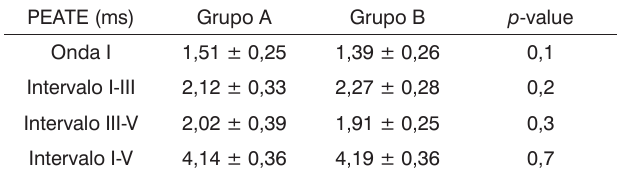
Tabela 3. Latências dos potenciais evocados auditivos de